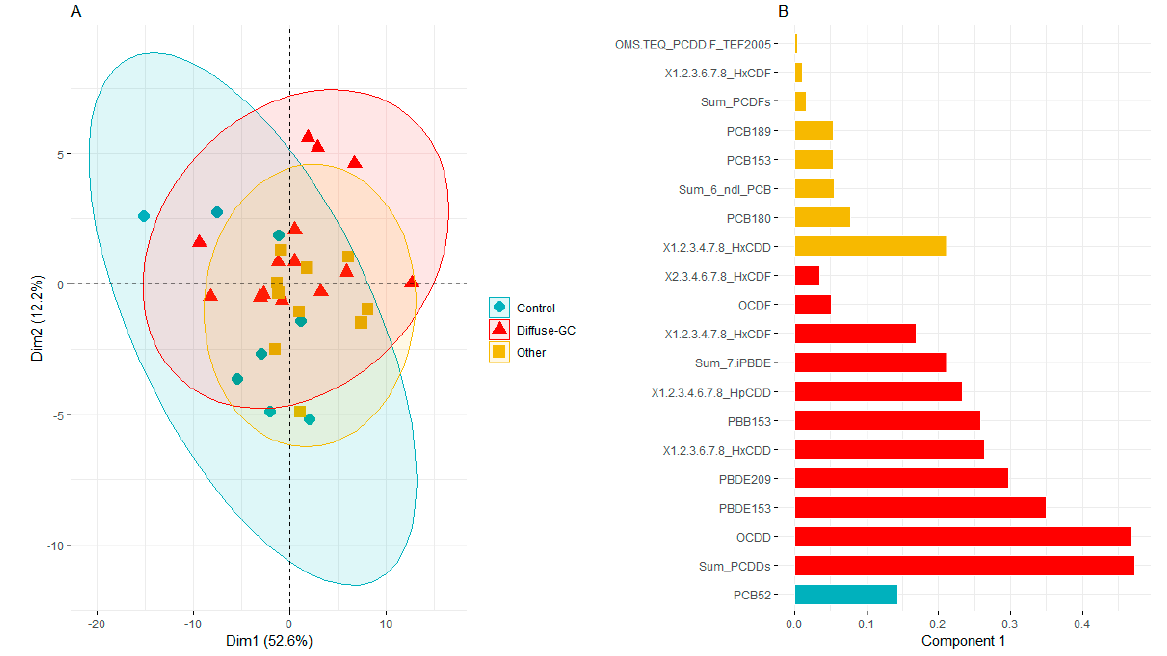
Figure 2. ( A ) The projection of individuals in the first two dimensions from the principal component analysis. ( B ) The contribution of each pollutant to the discrimination of three main groups (“diffuse-GC”; “other metastatic cancers”; and “control” groups, n = 32) is represented in the bar plot of loading weights computed from the first dimension from the sparse partial least square discriminant analysis. The color key in ( B ) indicates the group where the chemicals are more abundant.